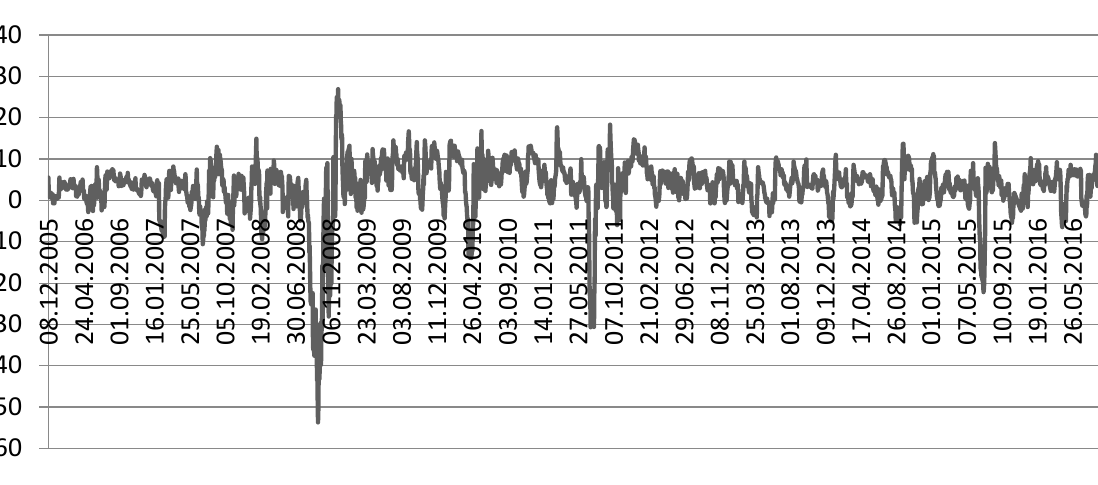
Figure 3. Evolution of 1 month volatility premium